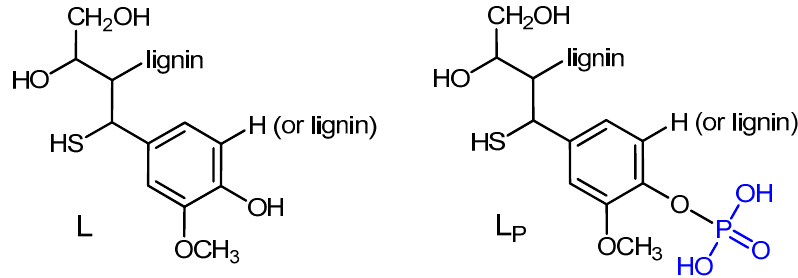
Figure 3. Phosphorylated guaiacyl units in the lignin structure.